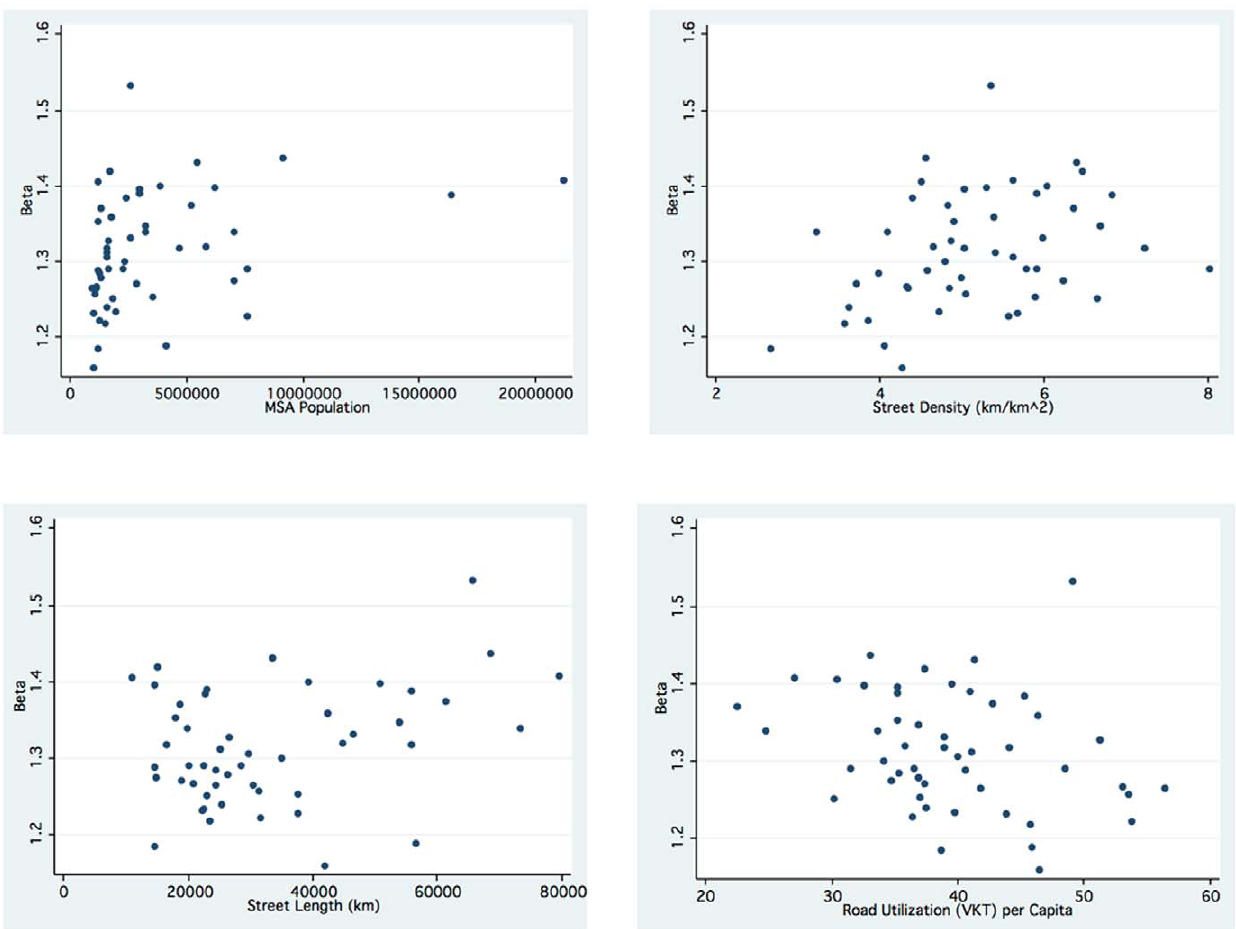
Figure 2. Beta vs. Population (slope=0.0297, r 2 =0.11, P =0.018), Street Length (slope=0.0421, r 2 =0.10, P =0.023), Street Density (slope=0.0991, r 2 =0.11, P =0.006), Road Utilization per Capita (slope= 2 0.0825, r 2 =0.07, P =0.06). Network connectivity ( b ) increases with population, road length, and road density, but declines with personal travel.